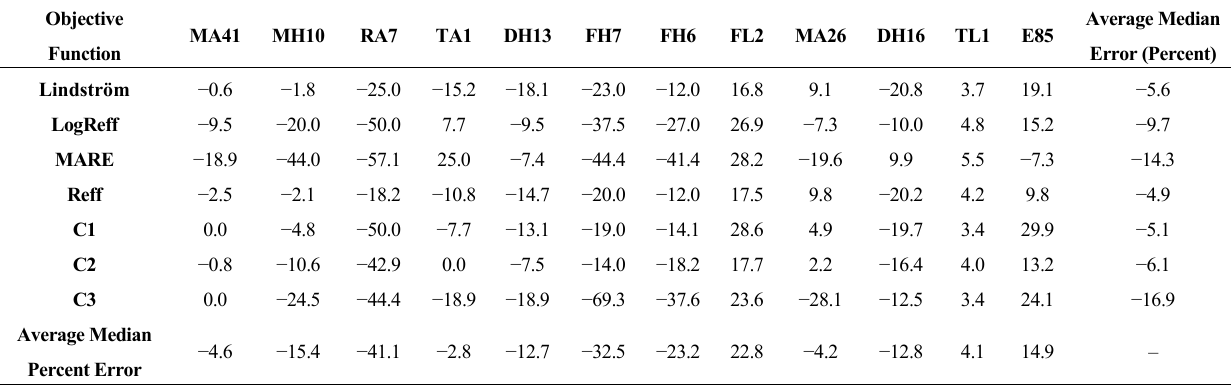
Table 8. Median percent error for streamflow characteristics by model objective function for calibration period 1